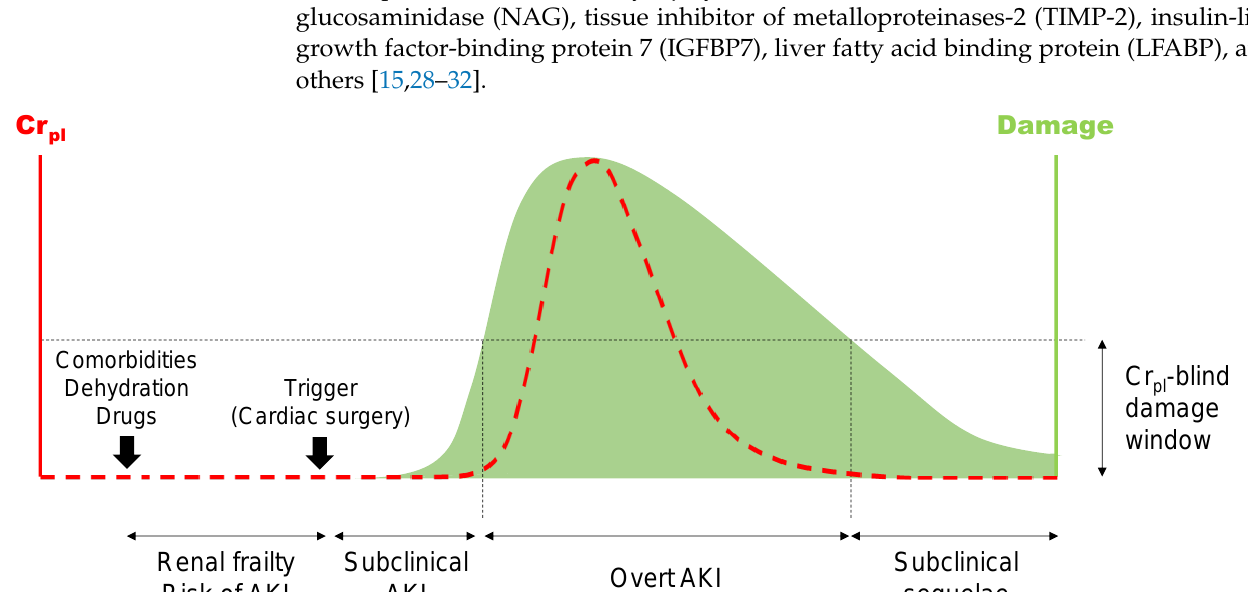
Figure 1. Stages of AKI potentially subject to diagnosis. AKI, acute kidney injury. Cr pl , plasma creatinine concentration.